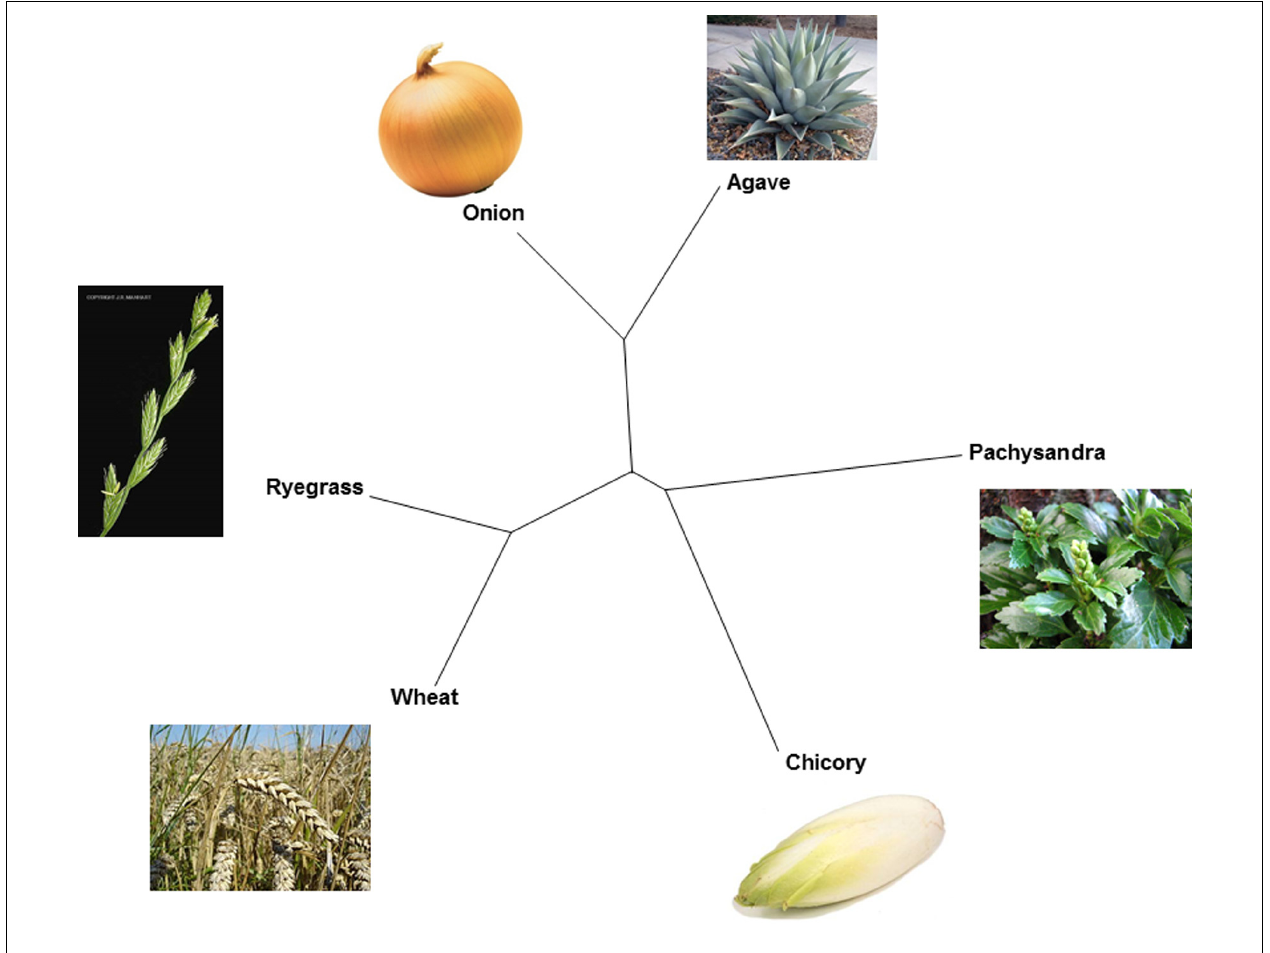
FIGURE 1 | Fructan diversity and polyphyletic origin of fructan biosynthesis in higher plants. An unrooted phylogenetic tree of fructan initiator enzymes (1-SSTs and a pFT) derived from six well-known fructan